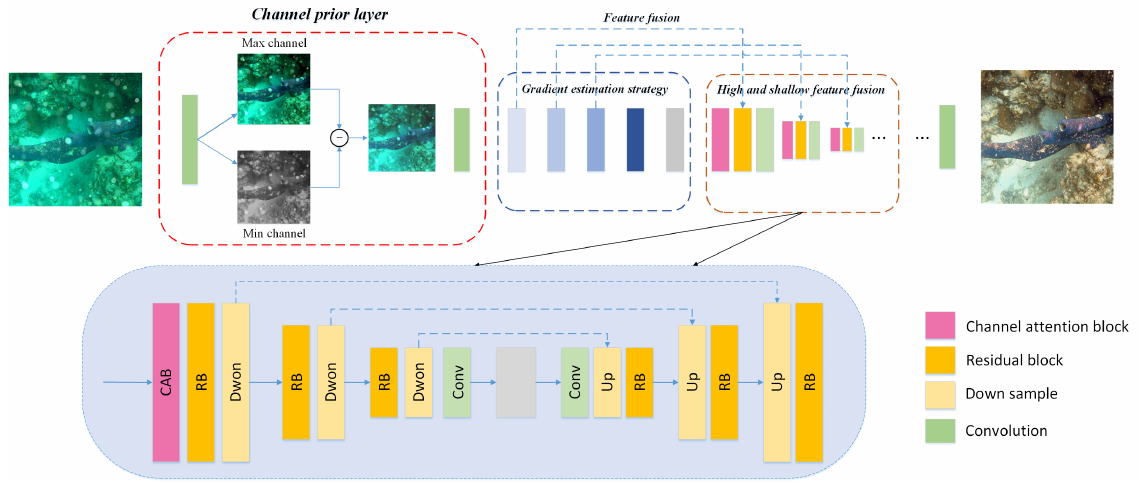
Figure 2. The structure of UIR-Net. It follows the encoder–decoder